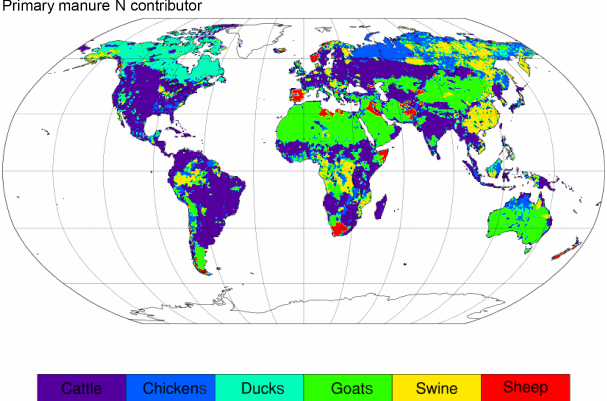
Figure 5. Spatial distribution of the primary contributors to manure nitrogen production in the year